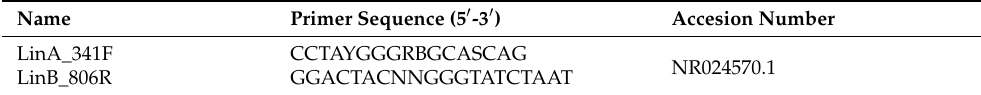
Table 3. Forward (F) and reverse (R) primers were used for PCR-test.